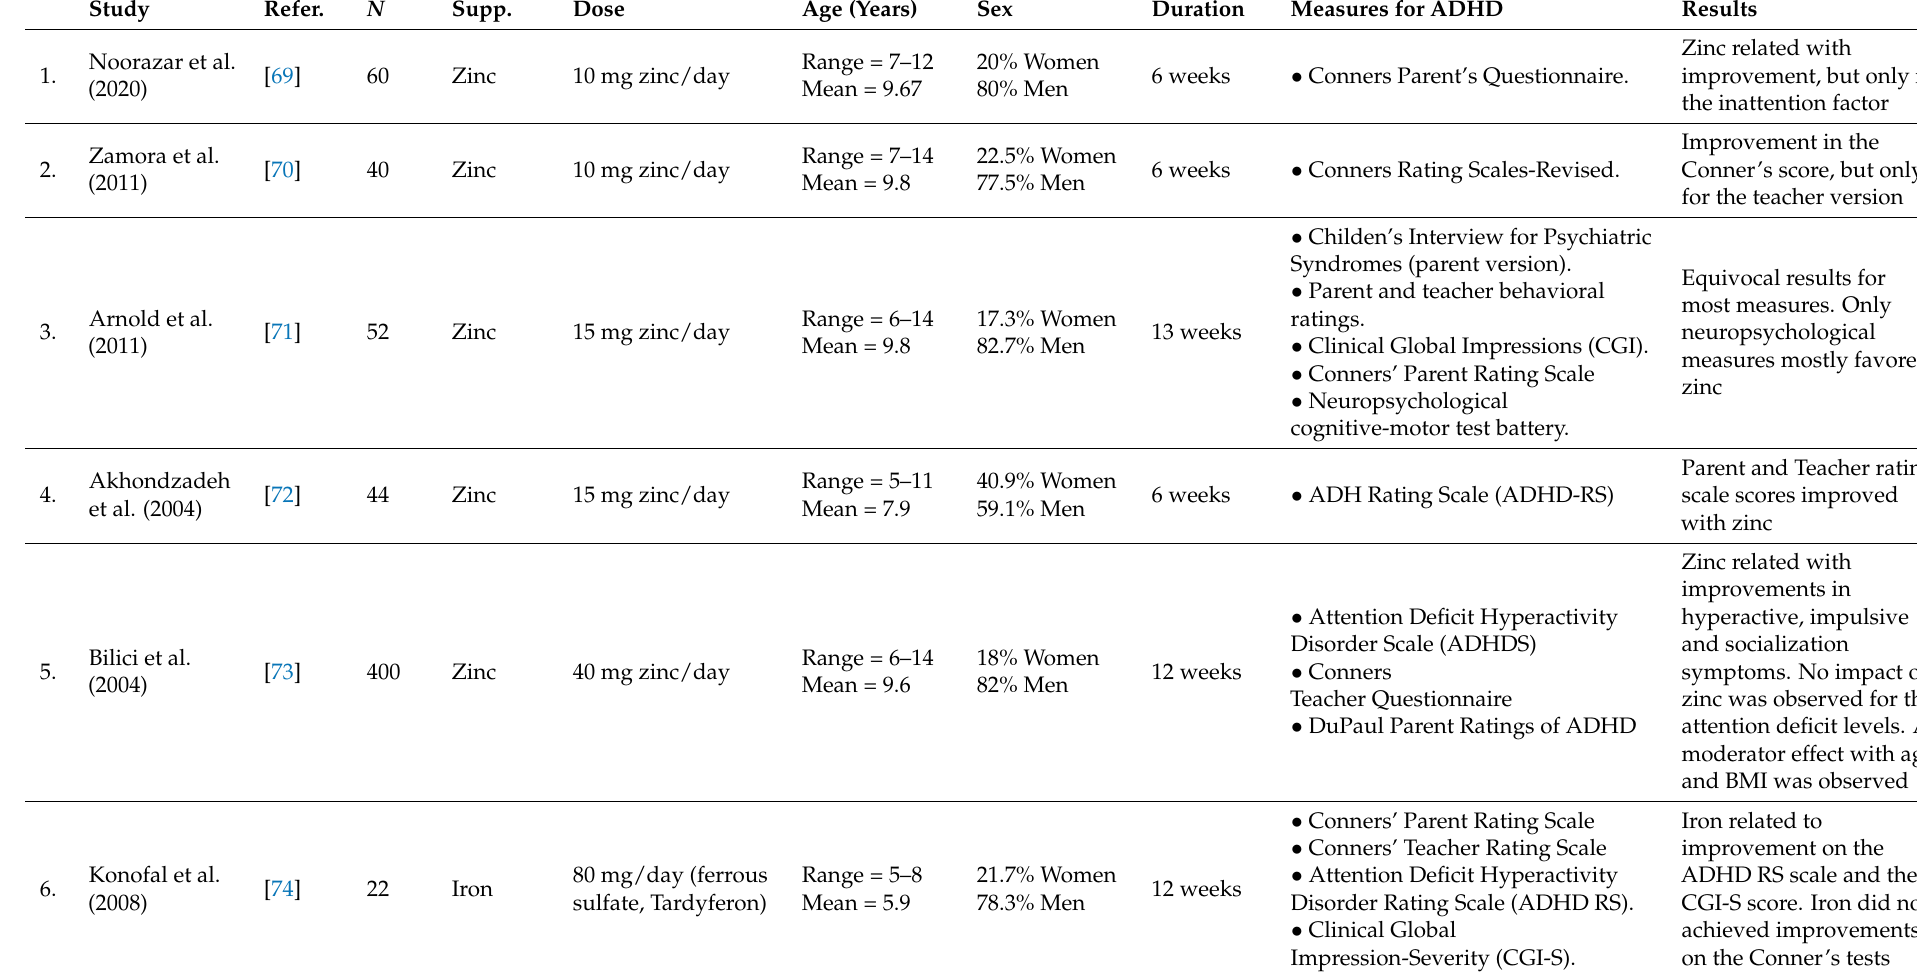
Table 1. Randomized controlled trials of supplements with iron and zinc for